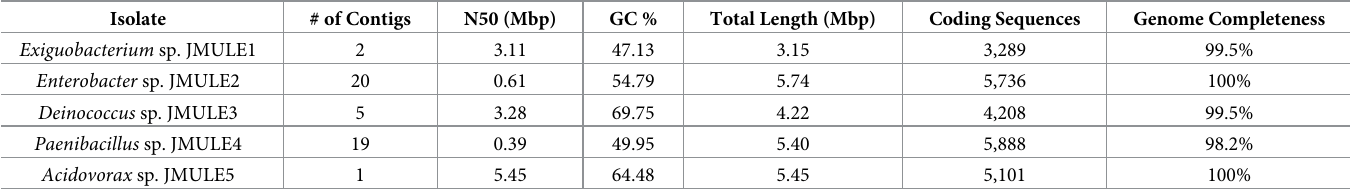
Table 1. Characteristics of genome assemblies obtained from the PacBio de novo assembly pipeline in the CLC Genome Finishing Module. Isolate